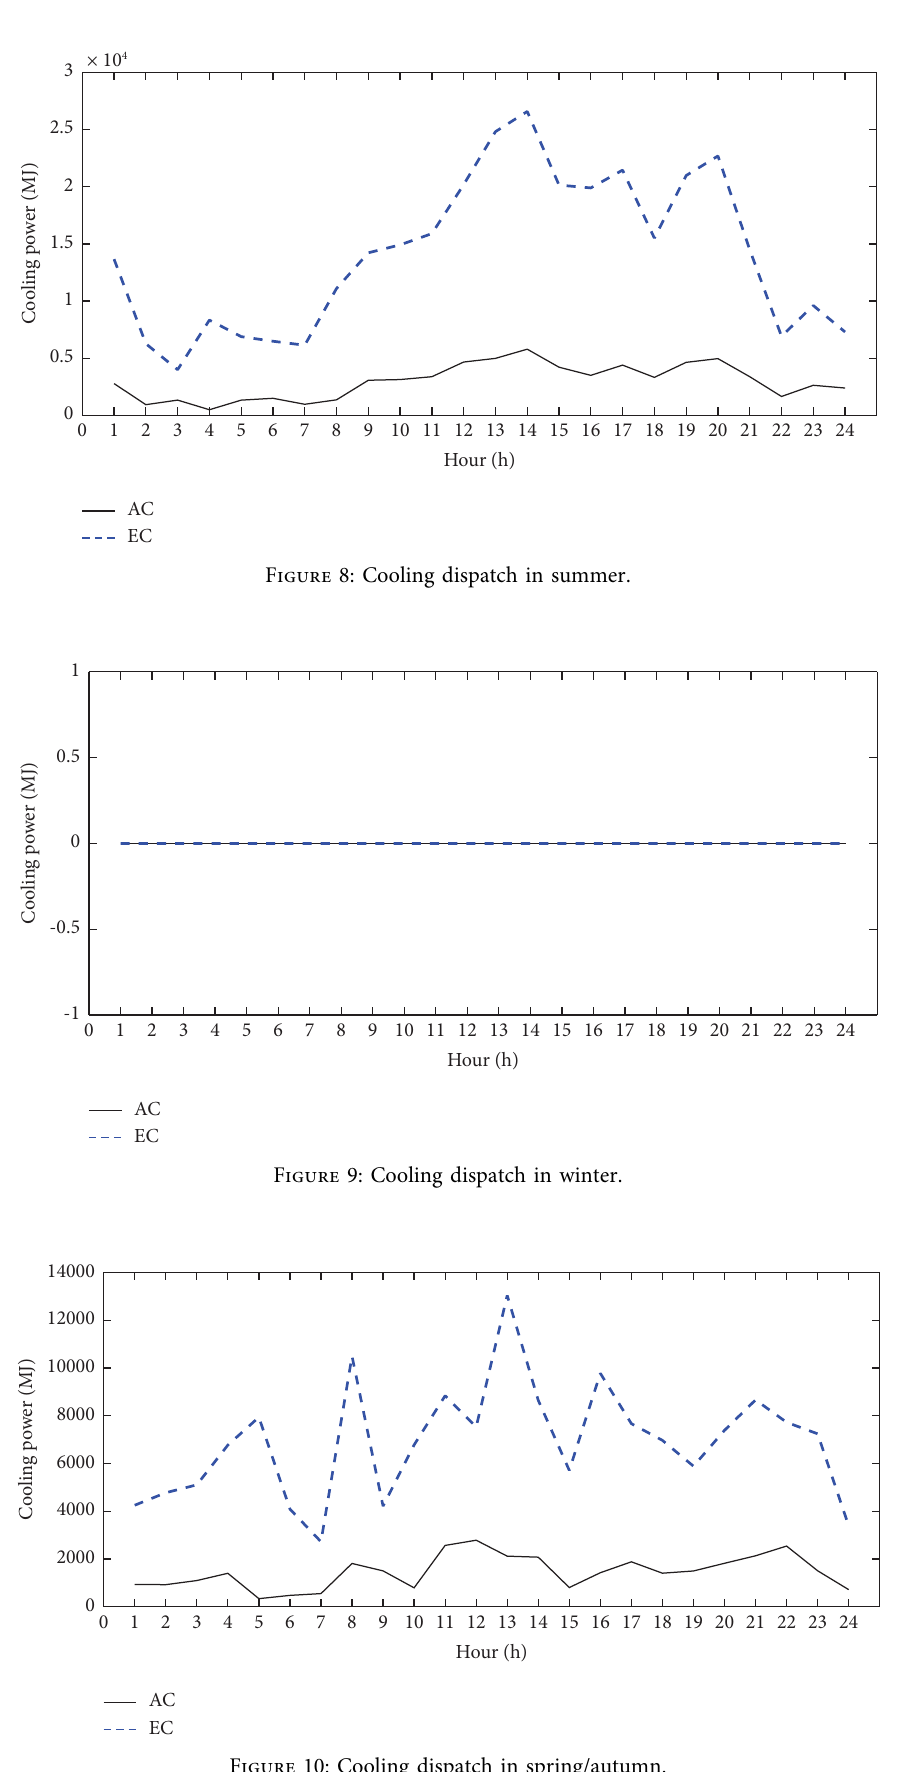
Figure 10: Cooling dispatch in